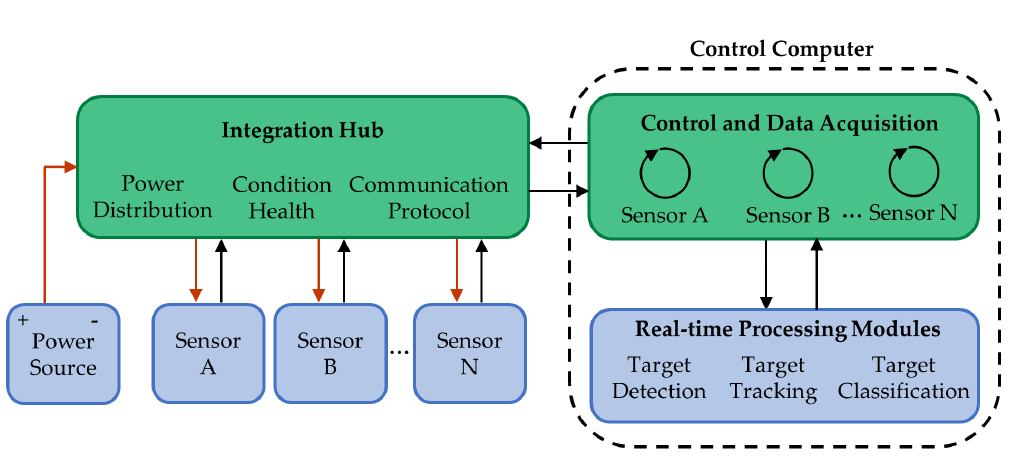
Figure 1. AMP architecture schematic. Black arrows denote flows of data, red arrows denote flows of power, and shading differentiates between deployment-specific (blue) and deployment-agnostic (green)